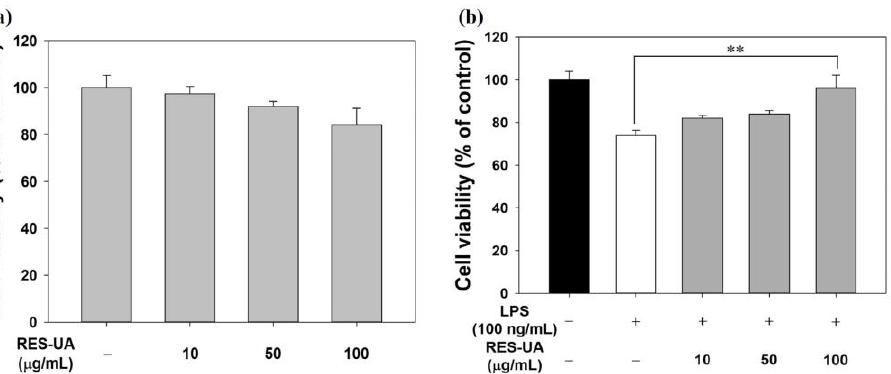
Figure Figure 4. ( a ) Cytotoxic effects of various concentrations of RES-UA NPs against RAW 264.7 macro- phages. ( b ) Cell viability of macrophages exposed to various concentrations of RES-UA NPs with